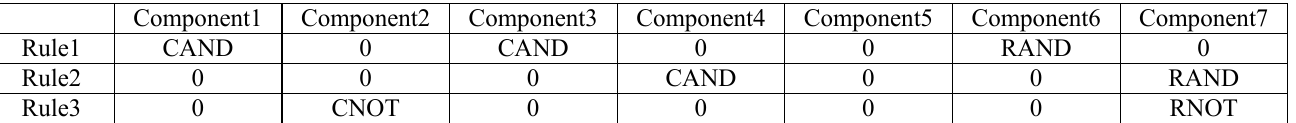
Table 1 contains three coded rules (by